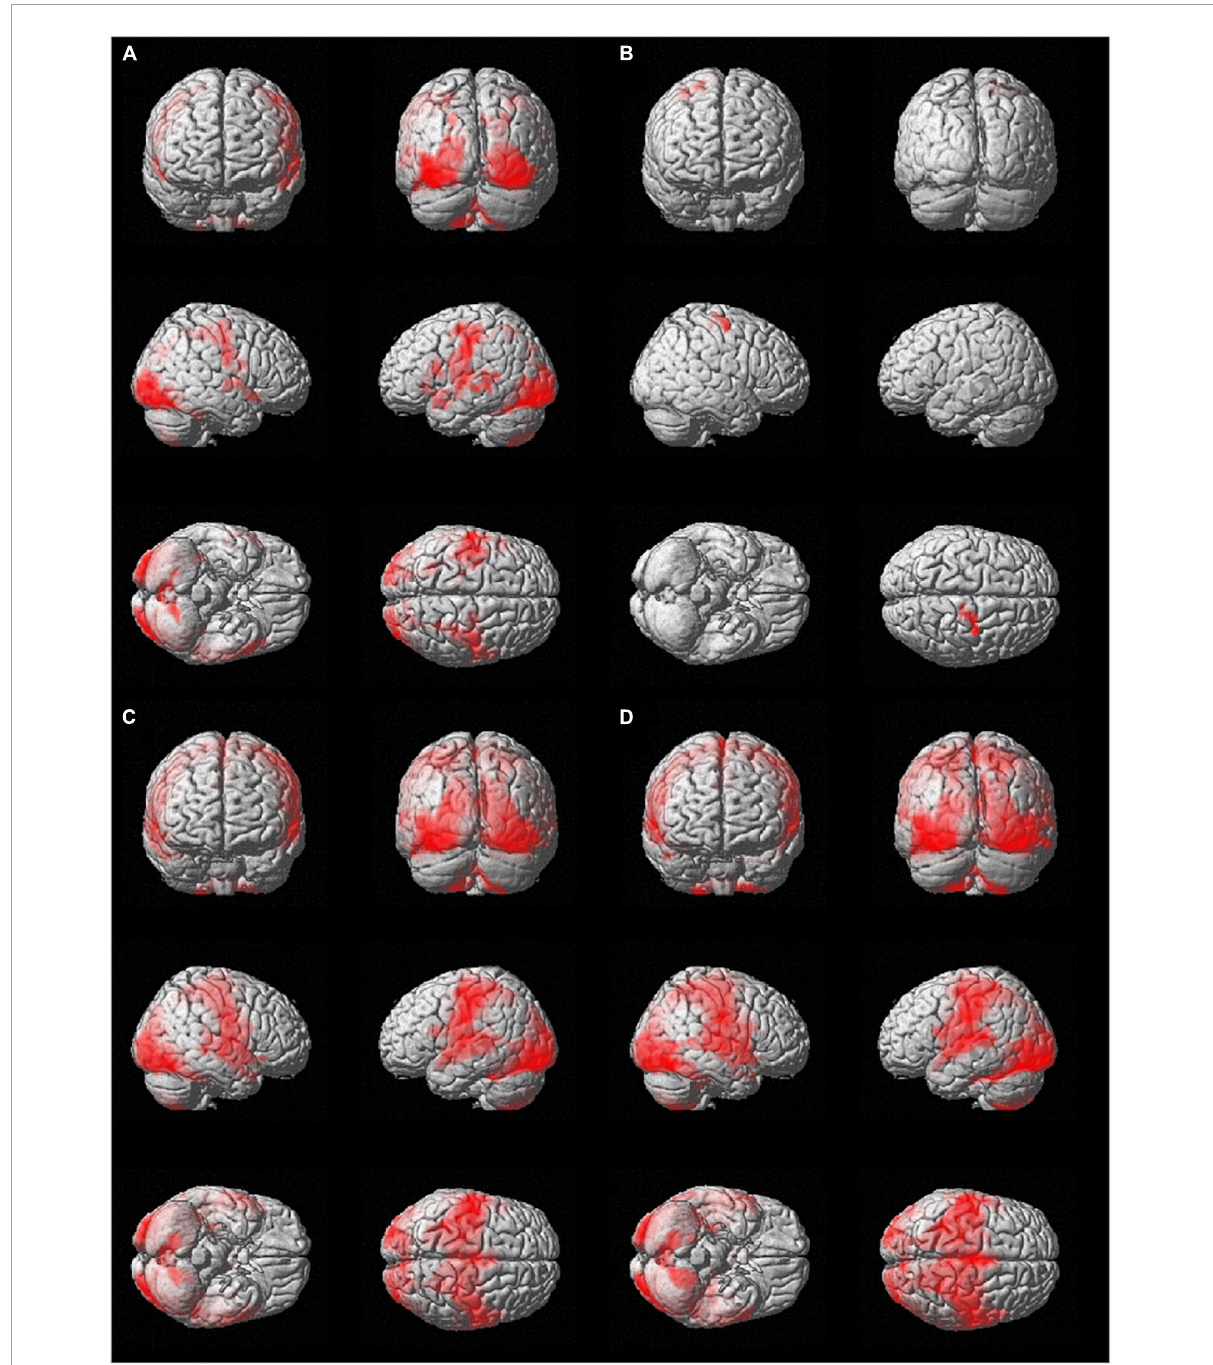
FIGURE2 Group seed-to-whole-brain functional connectivity results using as seeds (A) the l-hMHS, (B) the r-hMHS, (C) the l-BA4, and (D) the r- BA4. Voxels significantly connected with the different seed regions are displayed on a rendered surface ( p < 0.05 FWE-corrected, extent of threshold k = 20 voxels, height threshold t =